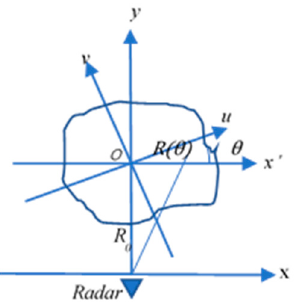
Figure 1. Inverse Synthetic Aperture Radar (ISAR) Imaging Model.